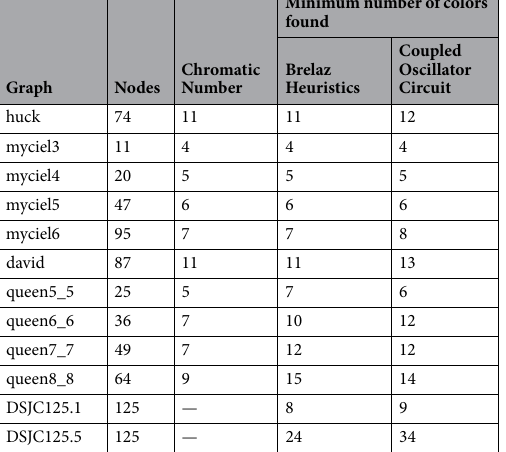
Coupled Oscillator Circuit